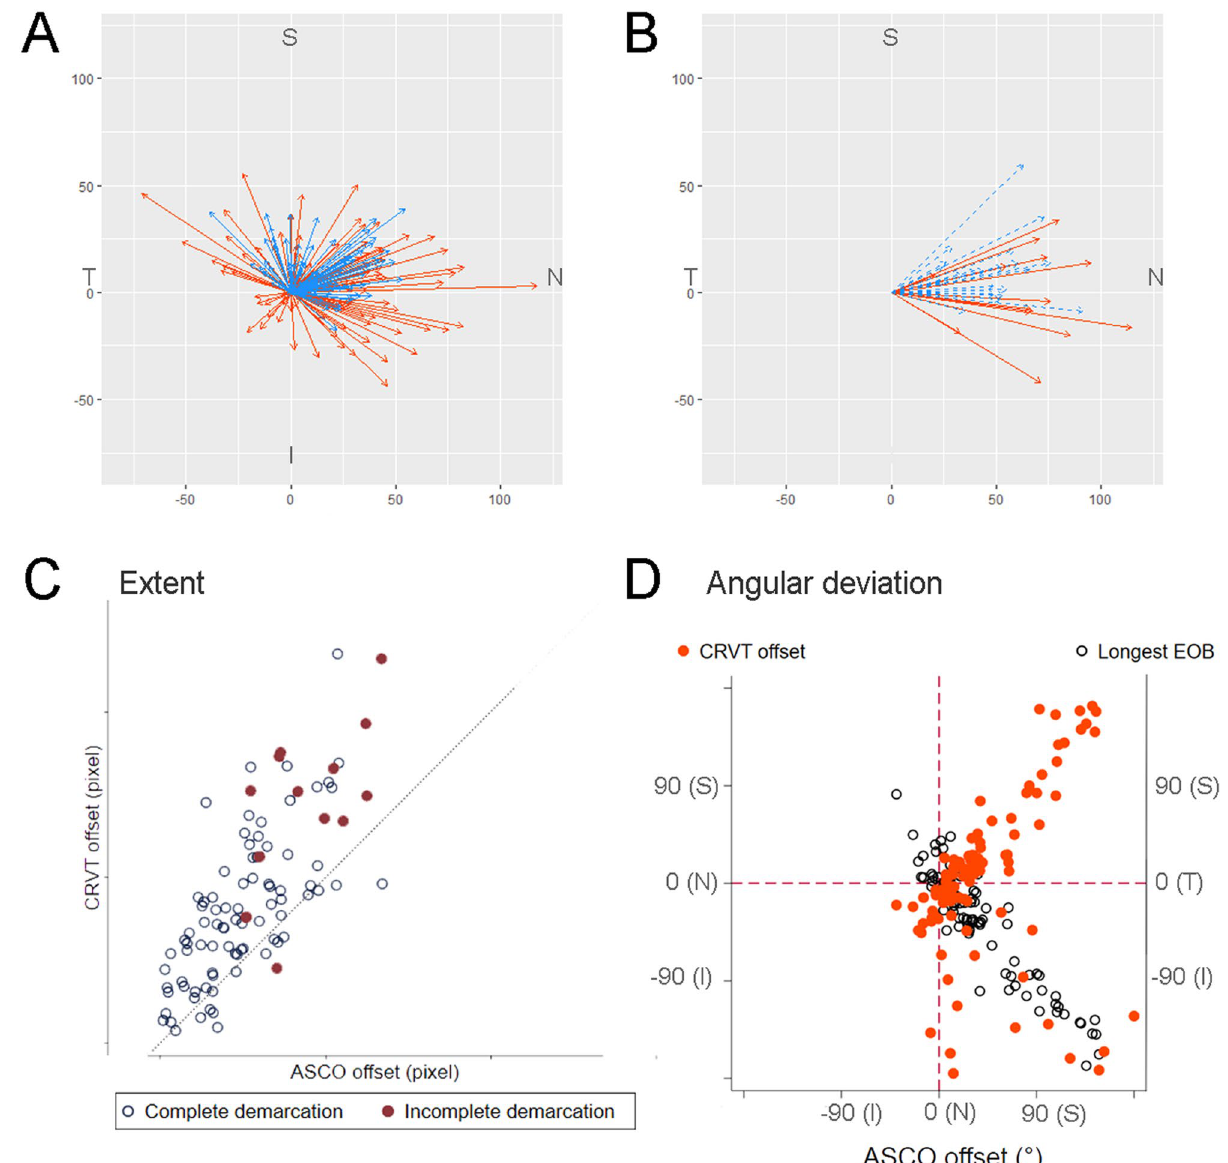
Figure 2. Offsets of anterior scleral opening (ASCO), central retinal vascular trunk (CRVT), and longest externally oblique border (EOB). ( A , B ) Vector fields comparing the CRVT (orange arrows) and the ASCO offsets (blue arrows) in eyes with complete ASCO demarcation ( A ) and in eyes with incomplete ASCO demarcation ( B ). Both offsets share directionalities, while extent is larger for CRVT offset than for ASCO offset. Please note that the eyes with the largest CRVT offset (shift index = 1.0) are not even drawn in the vector fields because we could not define the directionality for the CRVT offset in those cases. ( C ) Scatter plot comparing extent of CRVT and ASCO offsets within individuals by pixels. Regardless of complete or incomplete ASCO demarcation, CRVT offset tends to be larger than ASCO offset. The eyes with the largest CRVT offset (shift index = 1.0) were excluded from the analysis because we could not measure the exact pixel values of CRVT offset in those cases. ( D ) Scatter plot comparing angular deviations of CRVT offset, ASCO offset, and longest EOB. Please note that ASCO offset is barely deviated inferiorly. S = superior; T = temporal; I = inferior; N =